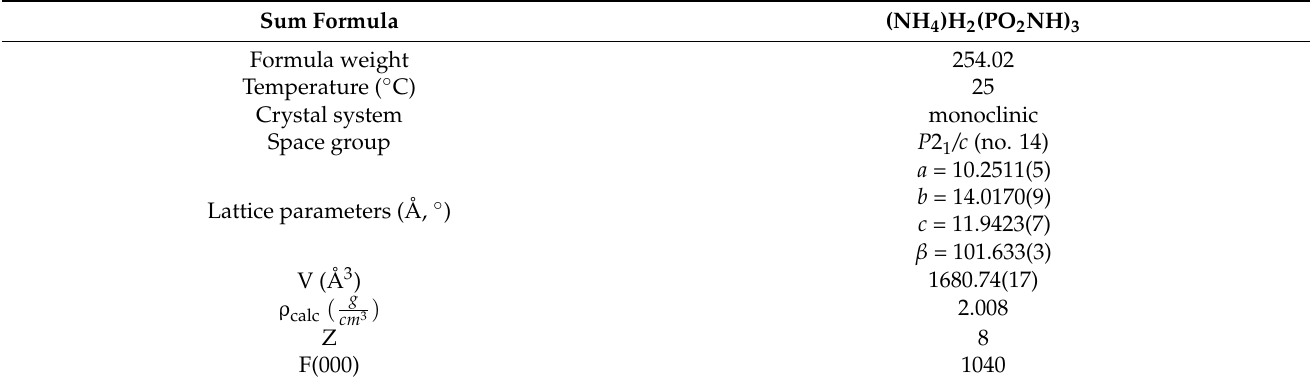
Table 2. Results of the SCXRD